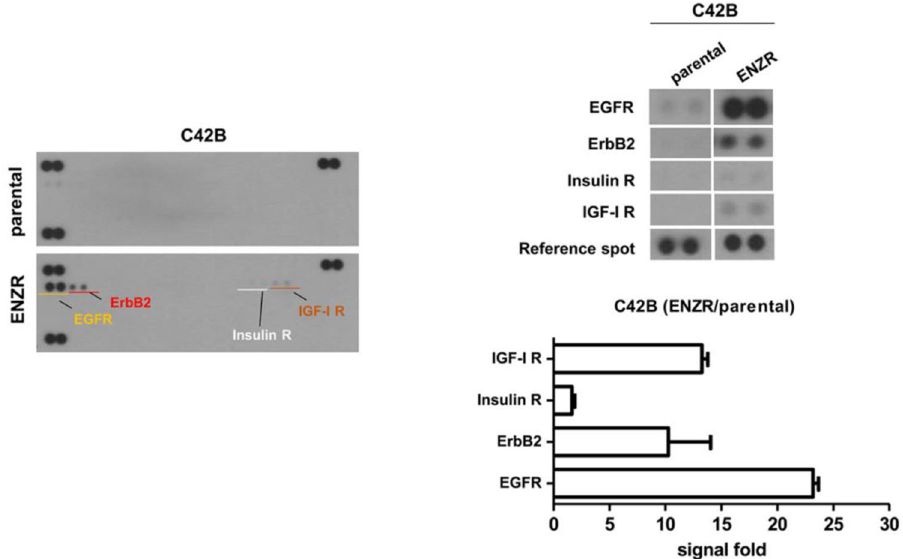
Figure 2. In vitro screening of enzalutamide resistant targets using RTK array analysis. ( a ) Representative blots of human receptor tyrosine kinase antibody array probed with protein lysates isolated from C4-2B cells carrying parental (upper) and ENZR (lower). ( b ) Individual RTKs are spotted and identification of phospho-EGFR, p-ErbB2, p-Insulin R and p-IGF-IR are indicated. Positive control spots are located at the corners of the human phospho-RTK array. ( c ) Spot intensity was quantified by densitometry and the data are presented in histogram format.